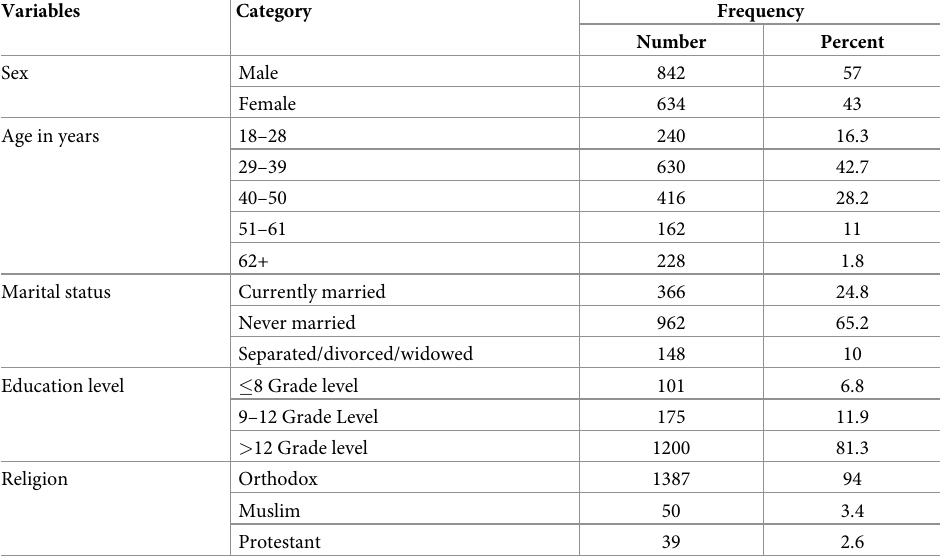
Table 1. Frequency distribution of socio-demographic characteristics of respondents in Northern Ethiopia (n = 1476).